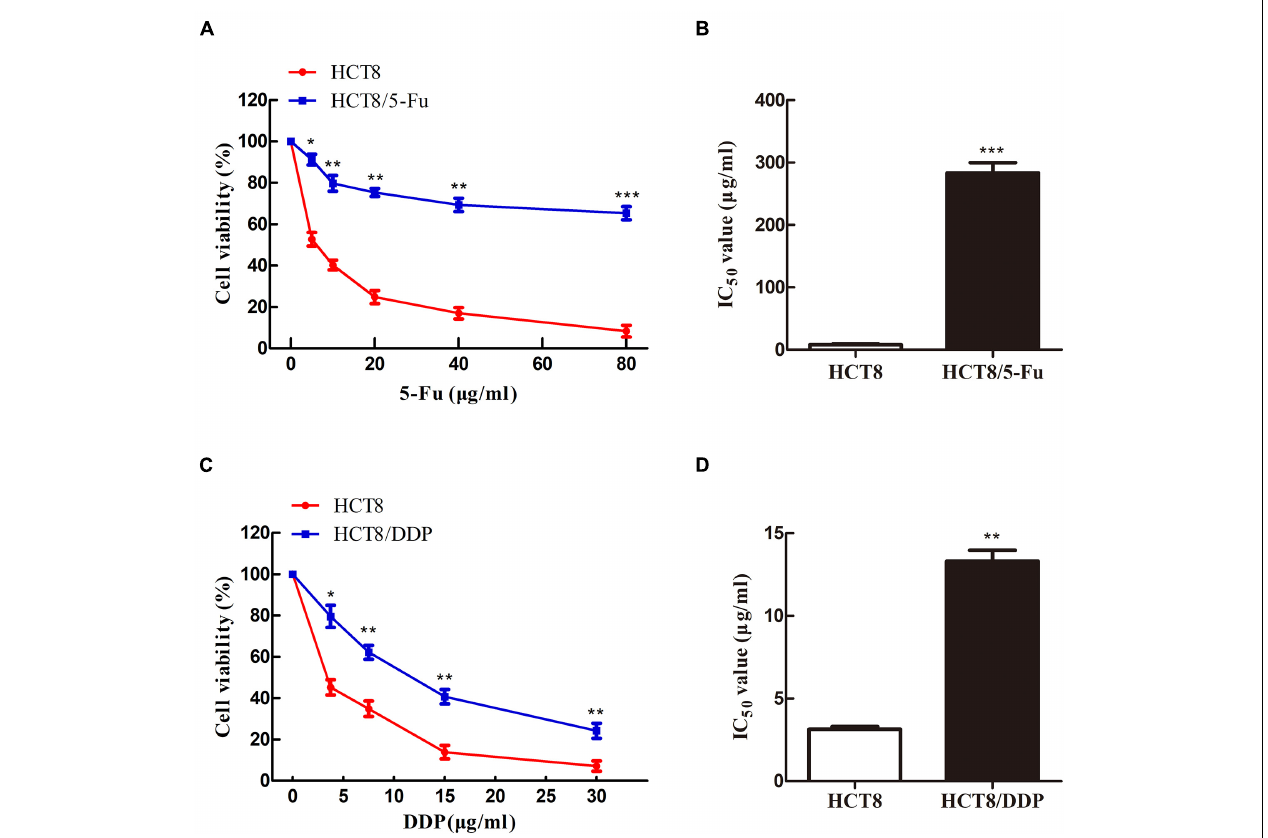
FIGURE 1 | HCT8/5-Fu and HCT8/DDP cells were more resistant to chemotherapy drugs. Cell viability and IC 50 of HCT8 and HCT8/5-Fu cells (A,B) , HCT8, and HCT8/DDP (C,D) were assessed by MTT assay. * p < 0.05; ** p < 0.01 and *** p < 0.001.